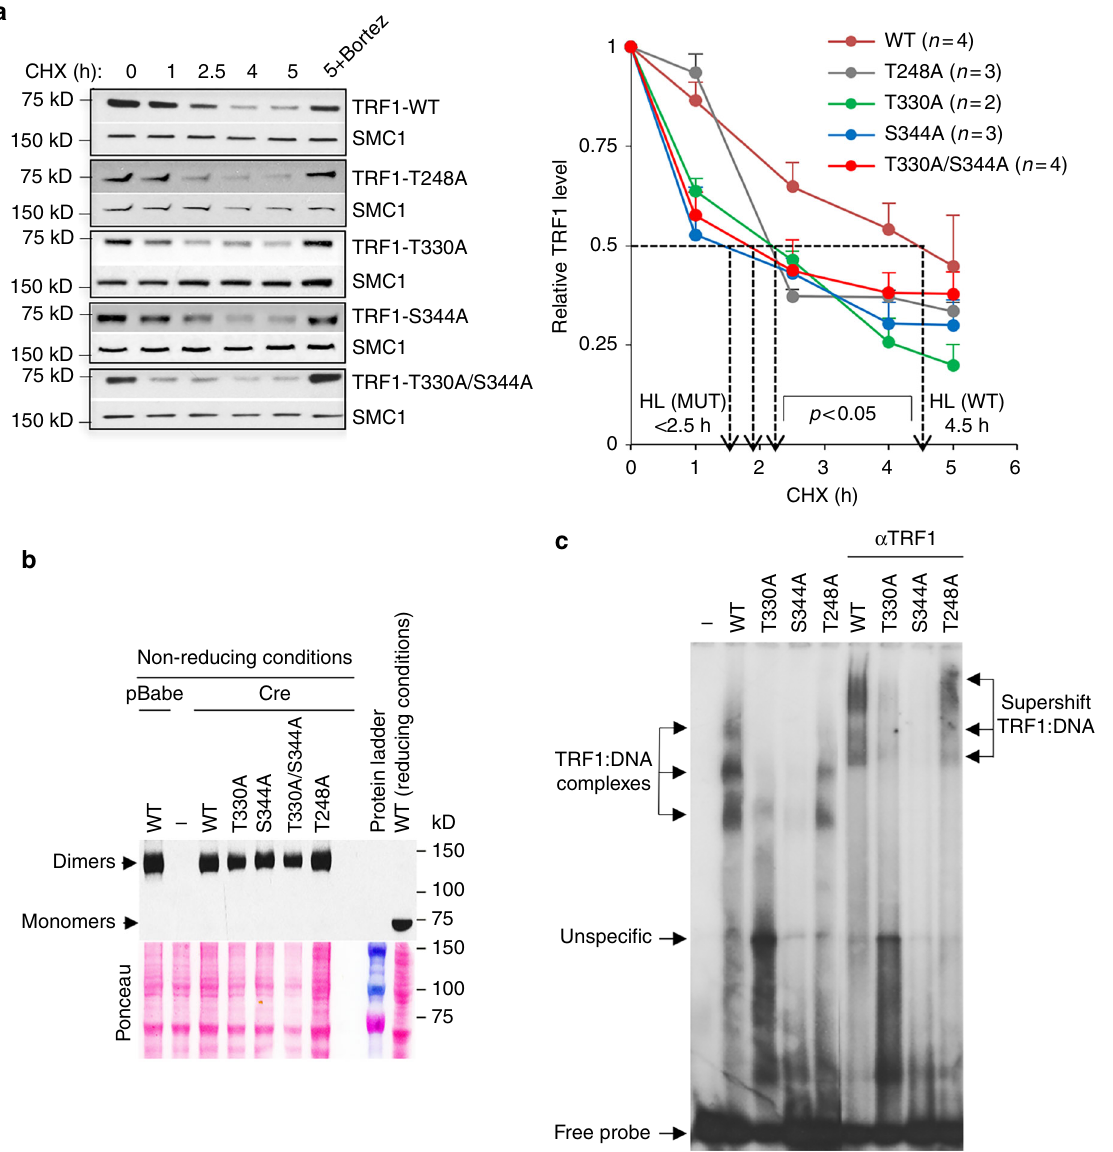
Fig. 7 AKT-mediated TRF1 phosphorylation regulate TRF1 protein stability and telomeric DNA-binding ability. a TRF1 protein half-life (HL) was determined in MEFs overexpressing eGFP - Trf1 WT or mutant ( Trf1 T248A , Trf1 T330A , Trf1 S344A , and Trf1 T330A/S344A ). Cells were pre-treated with 100 µ g/ml cyclohexamide (CHX) or bortezomib (5 µ M) for 30 min. At the indicated times, the cells were collected to prepare nuclear extracts, followed by western blot analysis against TRF1 or SMC1 (as loading control) (left). The graph represents the mean value for each time point and corresponding standard deviation (right panel). P values are indicated. b Trf1 lox/lox MEFS with or without overexpression of eGFP - Trf1 WT or mutant ( Trf1 T248A , Trf1 T330A , Trf1 S344A , and Trf1 T330A/ S344A ) alleles were transduced with the Cre recombinase to delete endogenous Trf1 . As control, Trf1 lox/lox MEFs overexpressing WT eGFP-TRF1 was infected with pBabe. Nuclear protein extracts were prepared in non-reducing conditions (without DTT) to detected TRF1 dimers. Western blot against TRF1 was performed in non-reducing conditions without heating in SDS-PAGE. A single sample corresponding to WT-TRF1 was loaded in reducing conditions to show the monomeric form of TRF1. Ponceau staining is shown as loading control (below panel). c In vitro TRF1 binding to telomeric dsDNA (TTAGGG) 7 assay was performed with GST-tagged TRF1 WT and mutant variants (T330A; S344A and T248A) as indicated by electrophoretic mobility shift assay (EMSA). Arrows show the positions of the three TRF1-containing complexes observed. As control for speci fi city of TRF1/DNA interactions, speci fi c